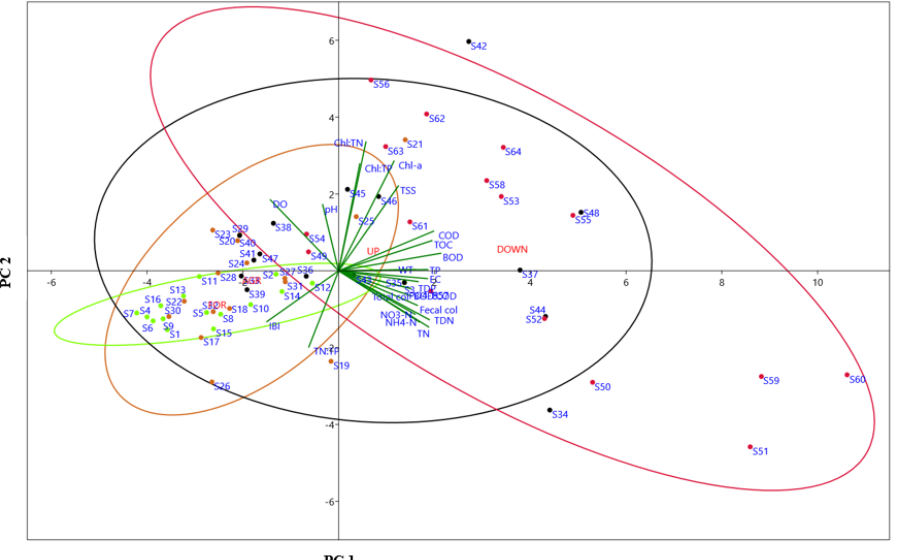
Figure 9. Principal component analysis among water quality parameters and IBI based on four land-use pattern streams (green: forest region, orange: agriculture region, black: urban upstream region, red: urban downstream region).